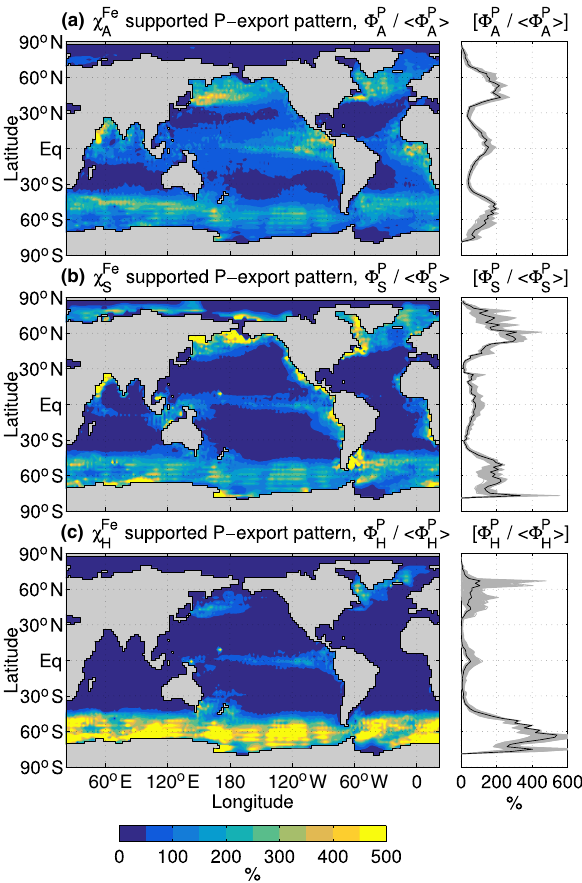
Figure 7. Phosphorus export supported by each iron type [aeo- lian (a) , sedimentary (b) , hydrothermal (c) ] normalized by its global mean. The maps show our typical state estimate, while zonal aver- ages of the normalized phosphorus export are shown for each family member in grey, with the typical state estimate in black.